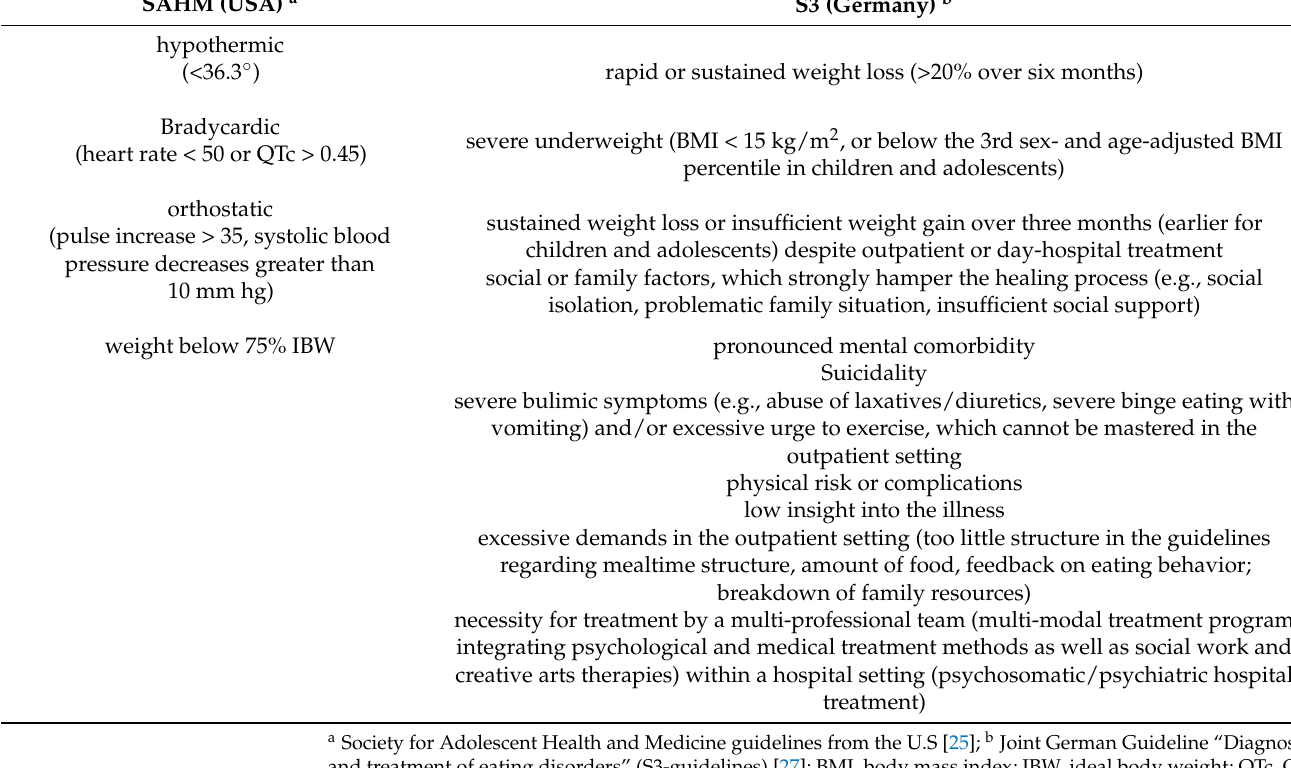
Table 1. Criteria for inpatient admission according to Society for Adolescent Health and Medicine guidelines from the USA (SAHM-guidelines) and Joint German Guideline “Diagnosis and treatment of eating disorders”